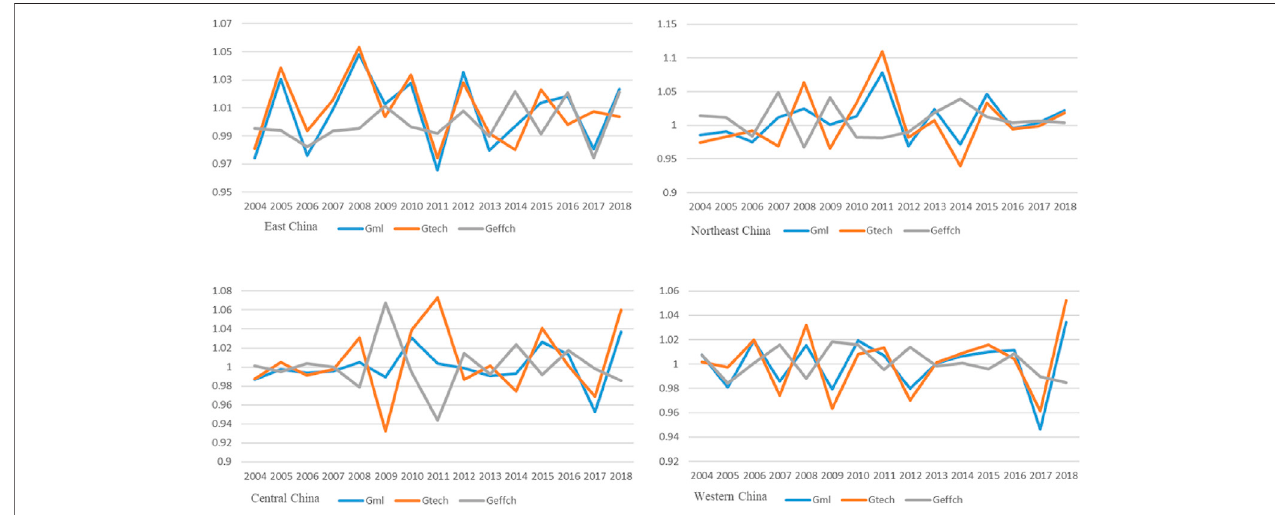
FIGURE 4 | The Gml, Gtech, and Geffch indexes of resource-based cities in four economic regions in China from 2004 to 2018.